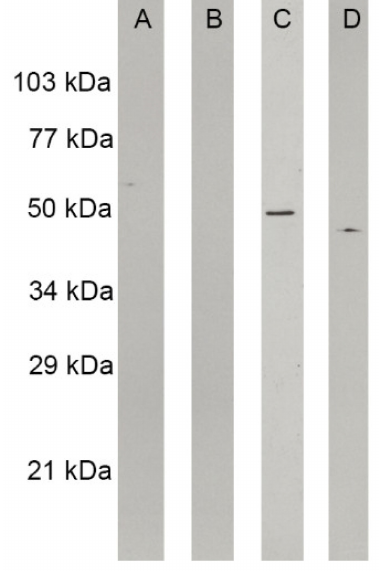
Figure 6. Influence of mebendazole in the Histoplasma capsulatum morphology. ( a ) H. capsulatum control; ( b ) H. capsulatum treated with mebendazole at optical microscopy (Bars: 20 µ m) and ( c ) Cel- lular diameter size of H. capsulatum yeast cells, treated with mebendazole and control (DMSO only). Microscopy images are representative of three independent experiments. The color lines inside the violins represent the median diameter size and the black lines the interquartile range of 100 measure- ments performed in triplicate. (**** p < 0.0001, Student’s t test).